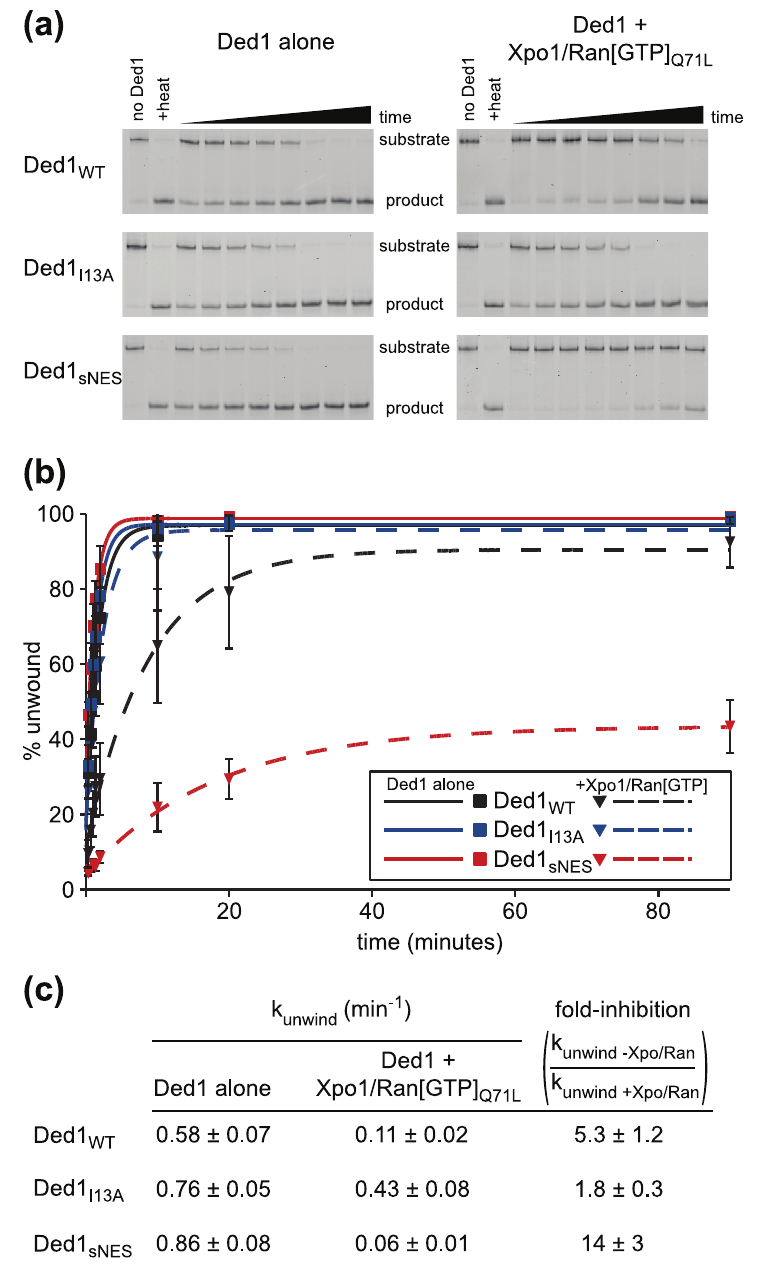
Fig 4. Xpo1 and Ran[GTP] reduce the RNA unwinding activity of Ded1. (a) RNA duplexes consisting of a FAM-labeled 13mer annealed to an unlabeled 41mer were incubated with Ded1 variants (50 nM) under unwinding conditions in the presence and absence of Xpo1 (550 nM) and Ran[GTP] Q71L (650 nM). The time points used for each experiment were 0.33, 0.66, 1, 1.33. 2, 10, 20, and 90 min. The reactions were monitored by native PAGE, with a representative gel shown from three independent experiments. (b) Quantification of RNA unwinding experiments. Each set of points represents the average of three separate experiments. Single exponential fits are shown for Ded1 variants alone (solid lines) and in the presence of Xpo1/Ran[GTP] Q71L (dotted lines). (c) Values for k unwind for data plotted in (b). The reductions in helicase activity upon addition of Xpo1 and Ran[GTP], given as fold-inhibition, are the ratios of k unwind values in the absence and presence of Xpo1 and